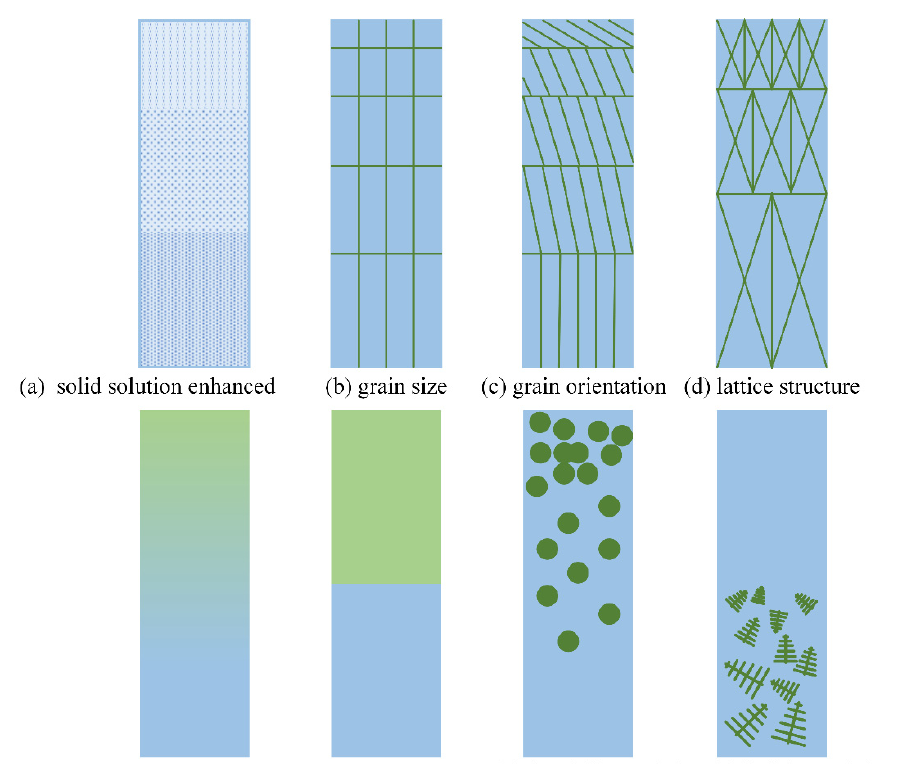
Figure 2. Schematic illustration of additively manufactured gradient metallic materials